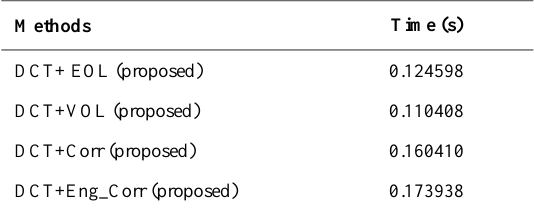
Table 5. Average Run-Time comparison between four proposed 512×512 multi-focus image fusion